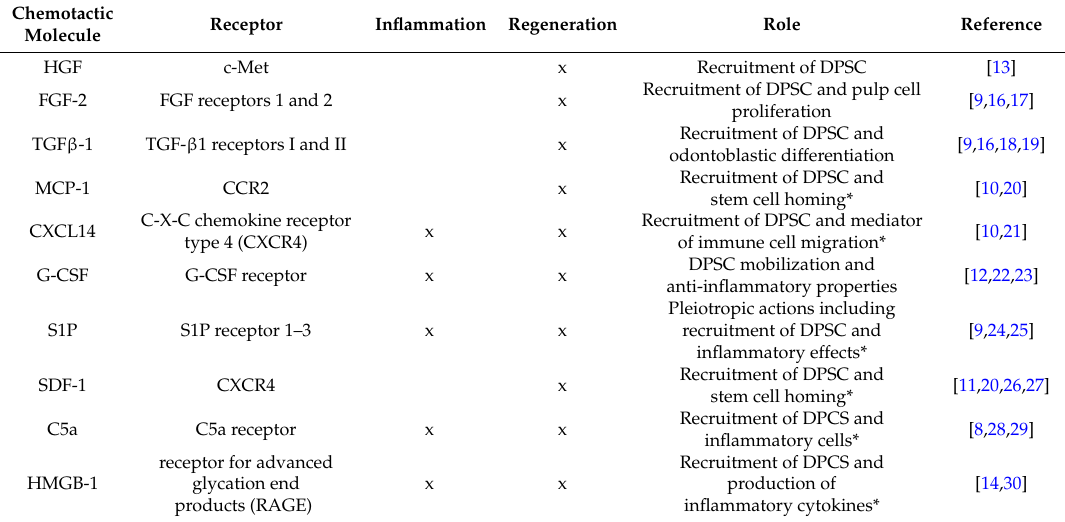
Table 1. Overview of migration signals for dental pulp stem cells (DPSC) with their corresponding receptors, and their specific roles in dentin pulp regeneration and